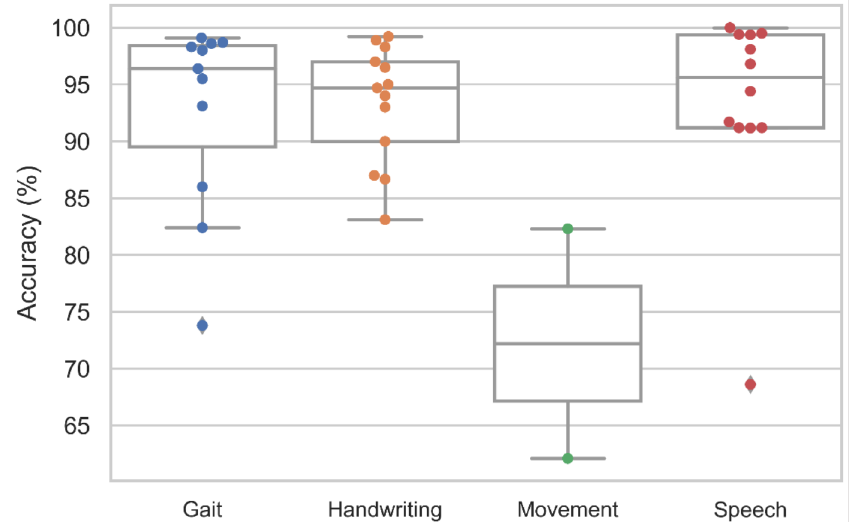
Figure 8. Box and whiskers plot of the model accuracy of deep learning studies using various modalities of motor